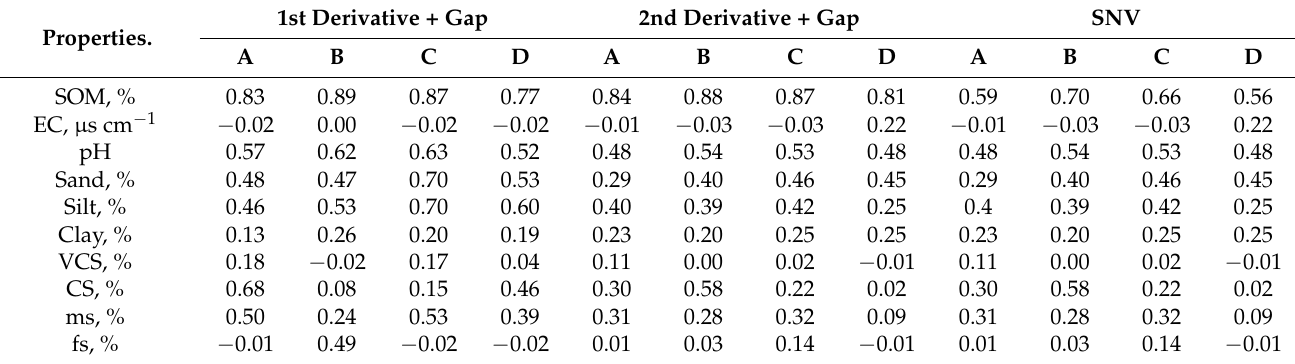
Table 8. The validation R 2 adj for various soil properties using selected best preprocessing and four modeling algorithms.